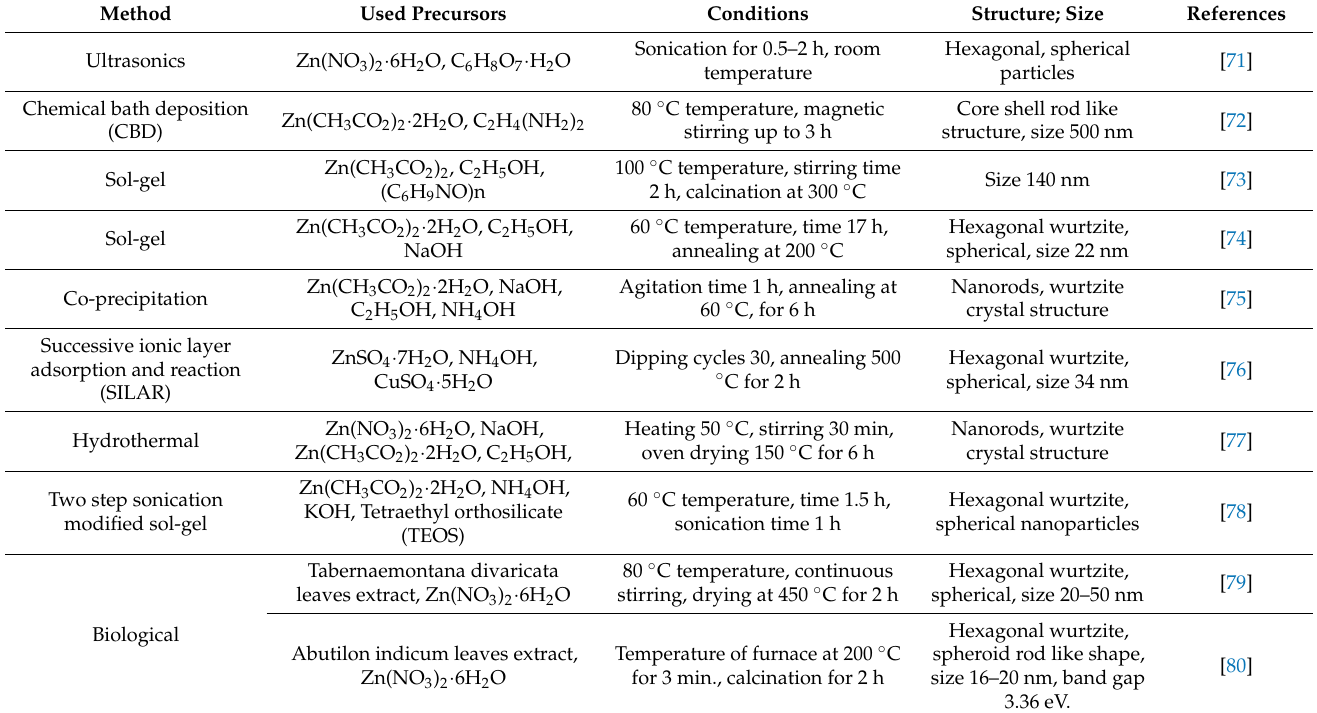
Table 1. Overview of some synthesis methods for nZnO.